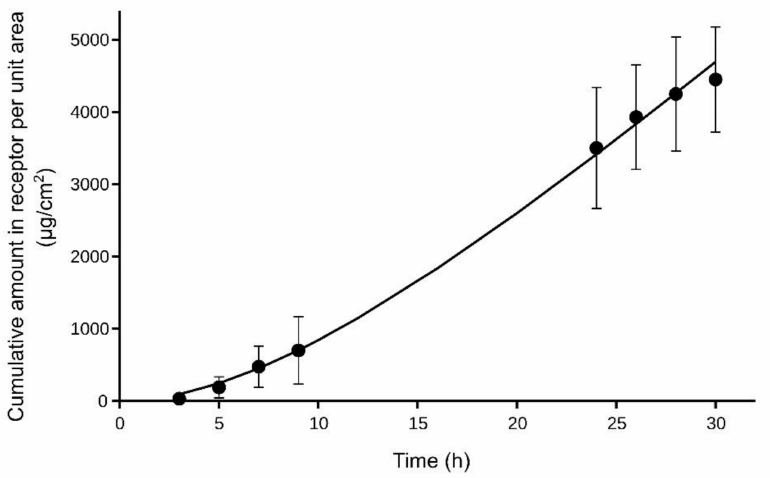
Figure 4. Cumulative amounts of NT (mean ± SD, n = 4) in the receptor chamber of the diffusion cells used in the in vitro skin permeation